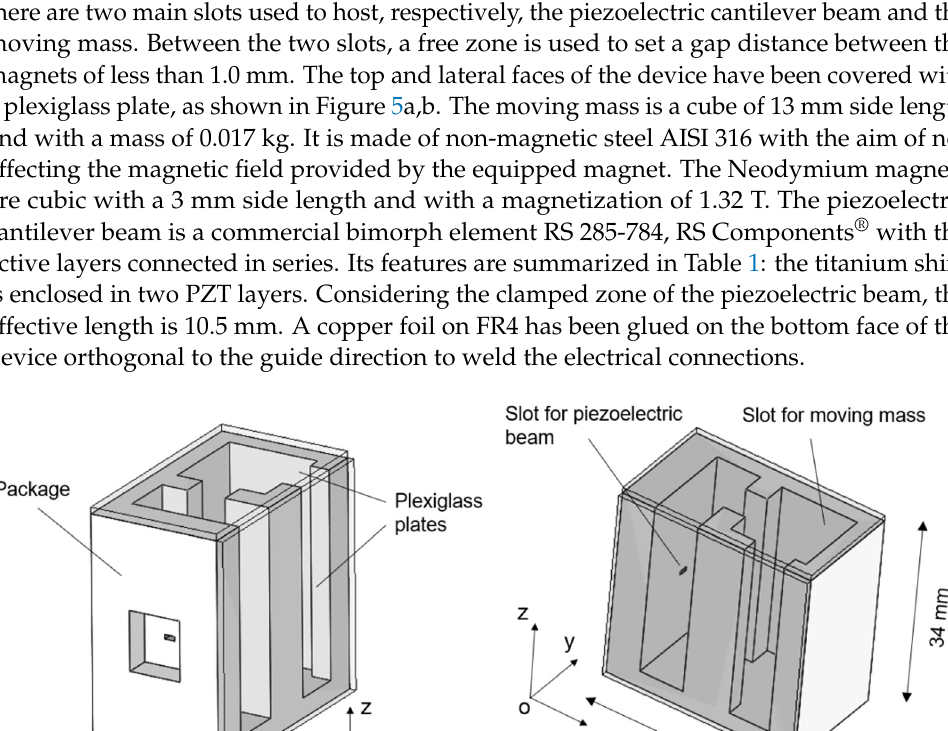
Figure 3. Qualitative total potential energy (TPE) function with respect to tip displacement W, for two versions of the system in Equation (1): ( a ) attractive configuration; ( b ) repulsive configuration with inter-well (1) and intra-well (2) mechanisms.